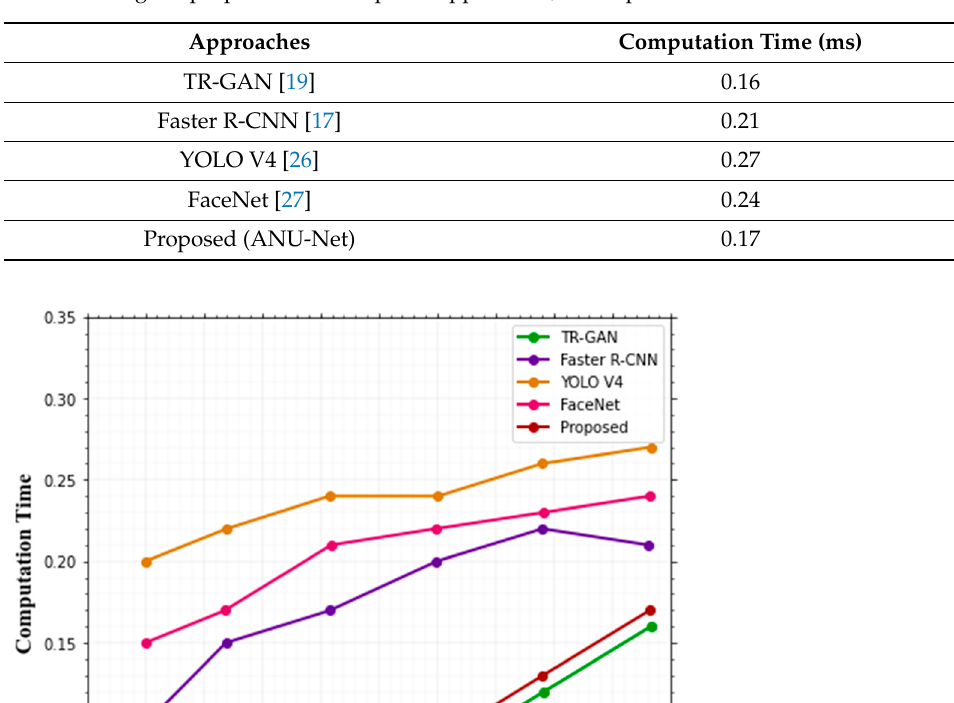
Table 5. Using the proposed and compared approaches, with optimization.